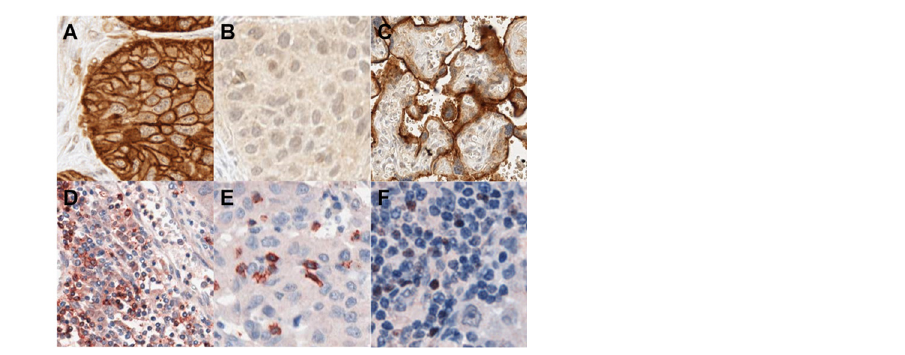
Fig 1. Representative images of immunohistochemical stains. (A) Strong PD-L1 staining. (B) Negative PD-L1 staining. (C) PD-L1 positive control. (D) CD8+ high stromal infiltrate. (E) CD8+ tumoral infiltrate. (F) FOXP3 positive stromal